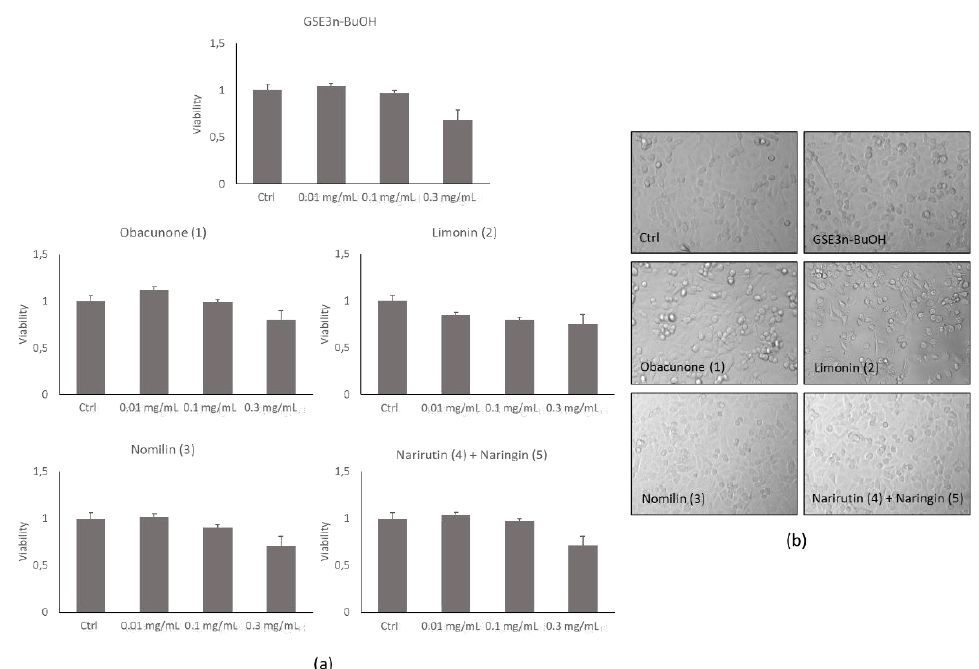
Figure 5. A549 cell viability and cell morphology of grapefruit seeds’ butanol extract ( GSE3 n-BuOH ) and isolated pure compounds (obacunone ( 1 ), limonin ( 2 ), nomilin ( 3 ), narirutin ( 4 ) + naringin ( 5 )). ( a ) Histograms of MTS cell viability assay. ( b ) Representative morphological images of untreated cells (Ctrl) and after 24 h from the addition of 0.1 mg/mL of the extracts and pure compounds.